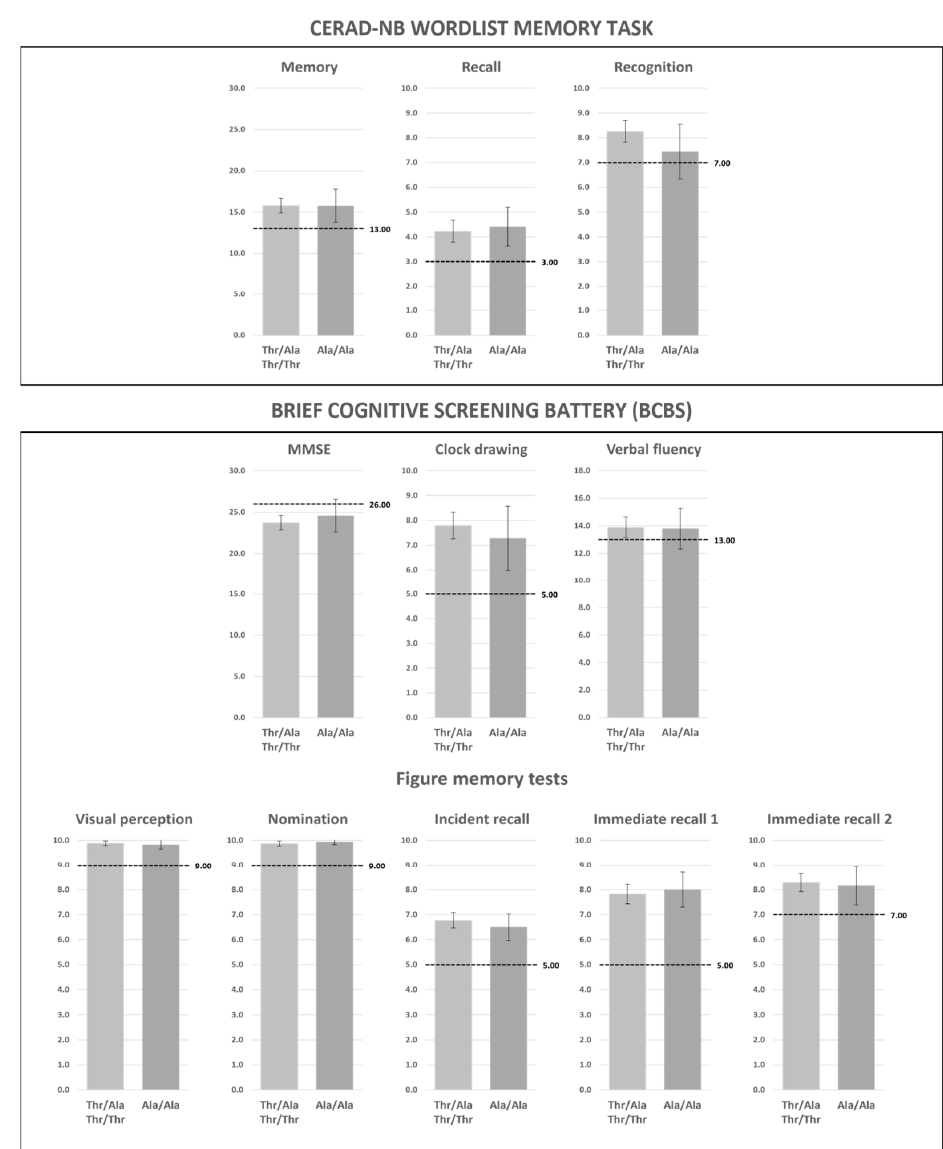
Figure 1. Cognitive tests results. Comparison between Ala/Ala and Thr/Ala-Thr/Thr genotypes following a recessive model. Scores are presented as mean; error bars indicate 95% confidence interval. Memory: p = 1.0. Recall: p = 0.7. Recognition: p = 0.1. Mini-Mental: p = 0.4. Clock drawing: p = 0.4. Verbal Fluency: p = 0.7. Visual perception: p = 0.6. Nomination: p = 0.5. Incident recall: p = 0.4.